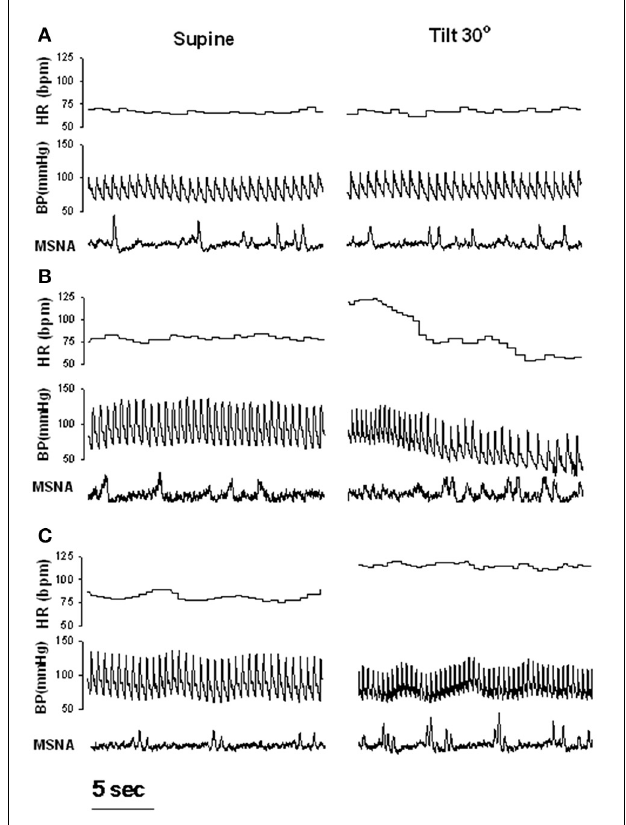
FIGURE 1 | Examples of heart rate (HR), blood pressure (BP) and muscle sympathetic nerve activity (MSNA) during supine rest and 30 degree tilt in one healthy control (A), one patient with recurrent vasovagal syncope (B), and one patient with postural tachycardia syndrome (C). Adapted from Vaddadi et al.